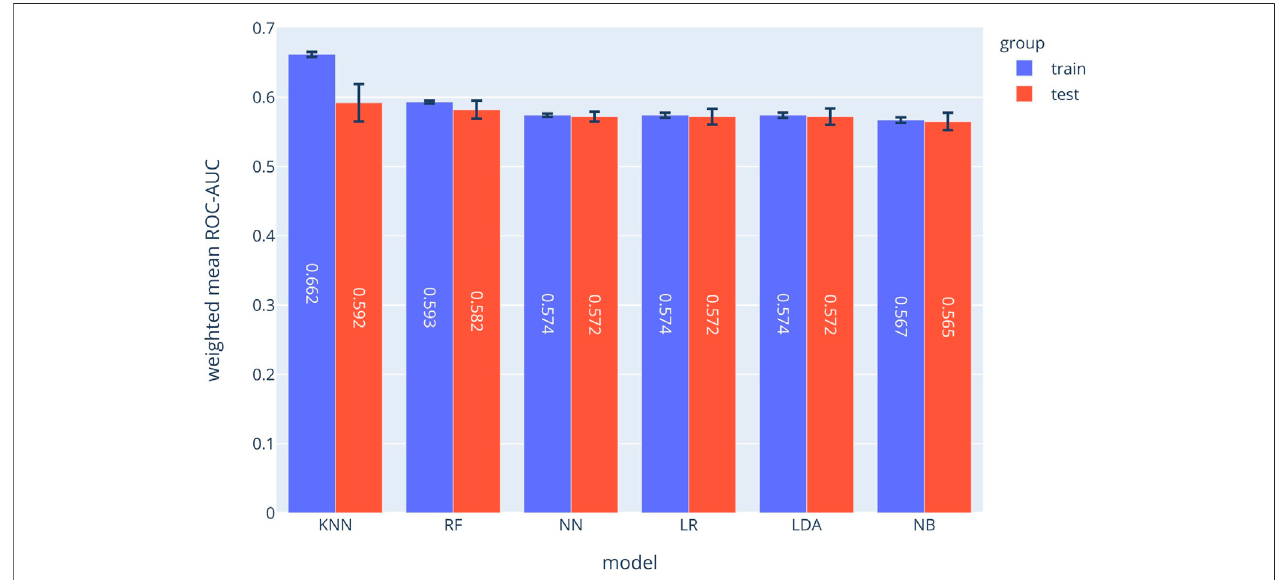
FIGURE 2 | ROC-AUCs of different ML models which were used to implement the MPM. The Random Forest (RF) model outperformed the other approaches.